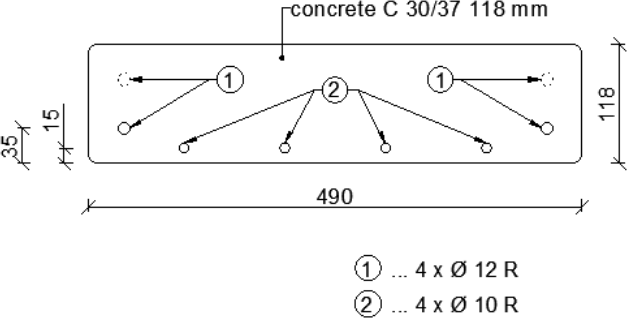
Figure 1. A typical geometry of the non-strengthened panels based on destructive investigations.